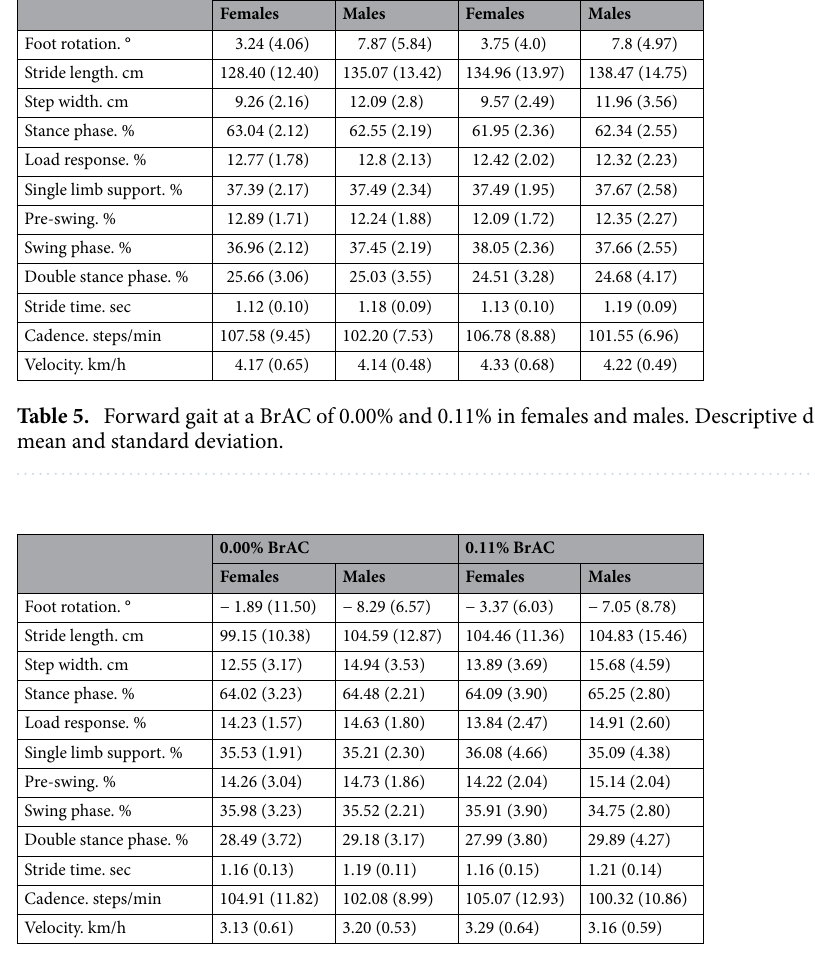
Table 6. Backward gait at 0.00% and 0.11% BrAC in females and males. Descriptive data are presented as mean and standard